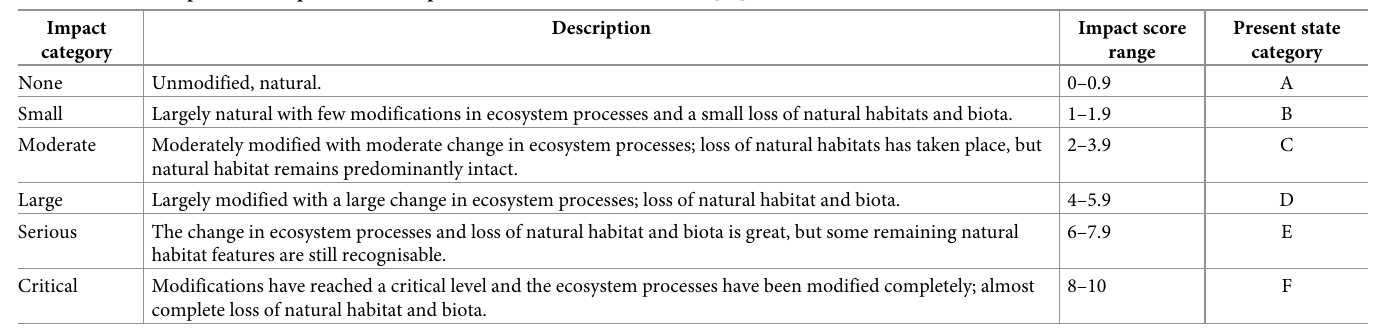
Table 3. Relationship between impact scores and present state of wetland condition